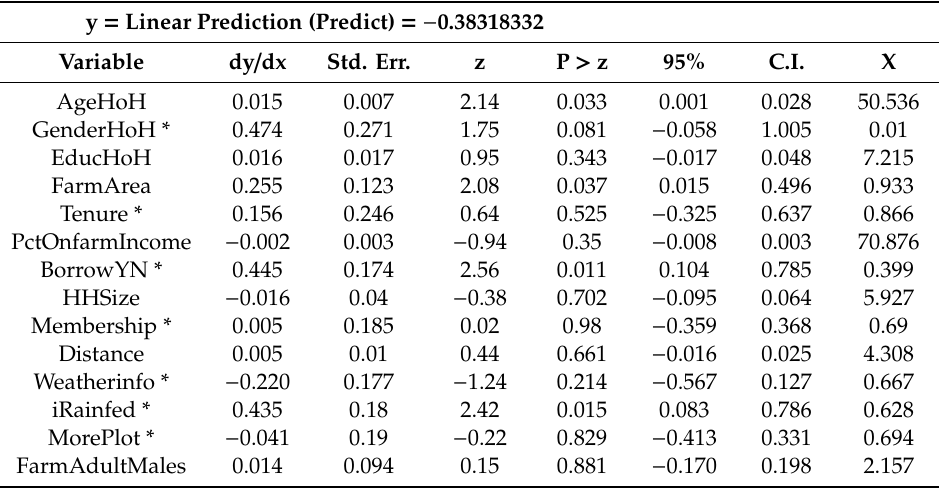
Table 4. Marginal e ff ect after multivariate probit analysis due to change in temperature. y = Linear Prediction (Predict) = −